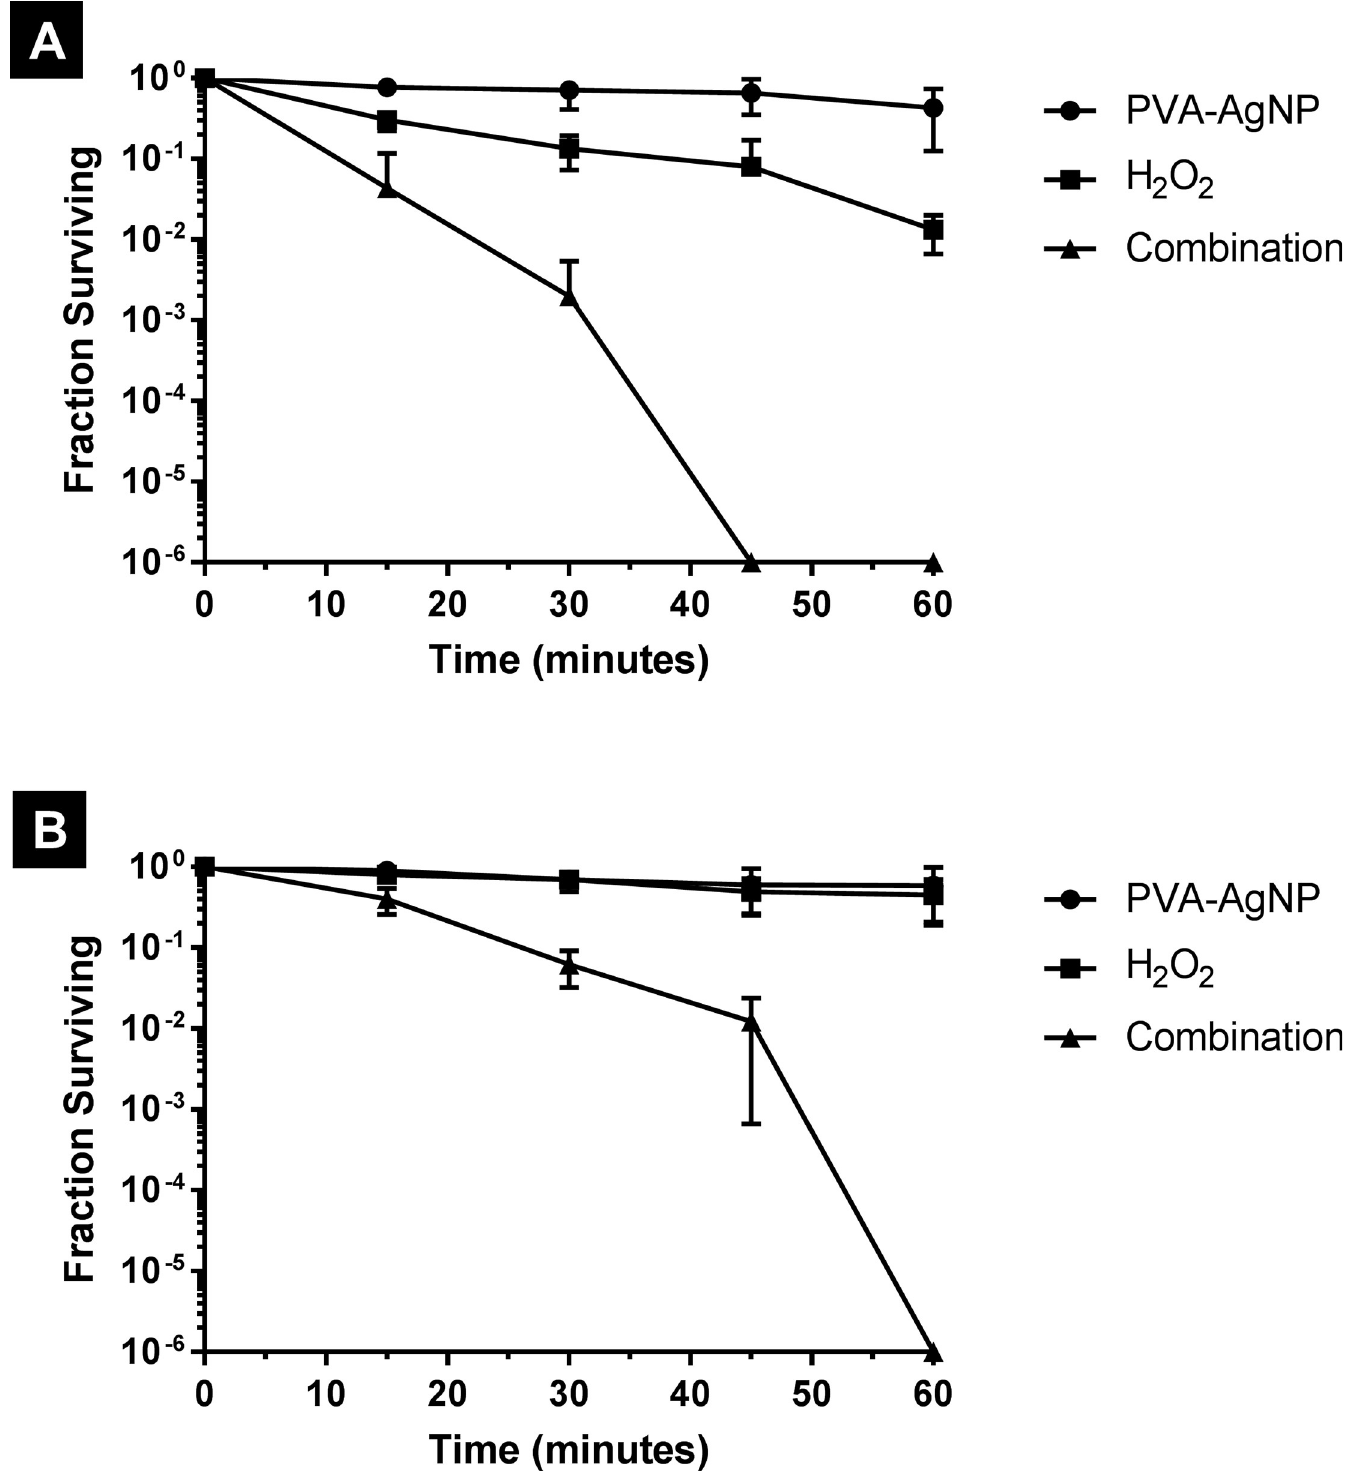
Fig 4. Survival curves of (A) E . coli and (B) S . aureus upon treatment with PVA-AgNP, hydrogen peroxide and their combination.